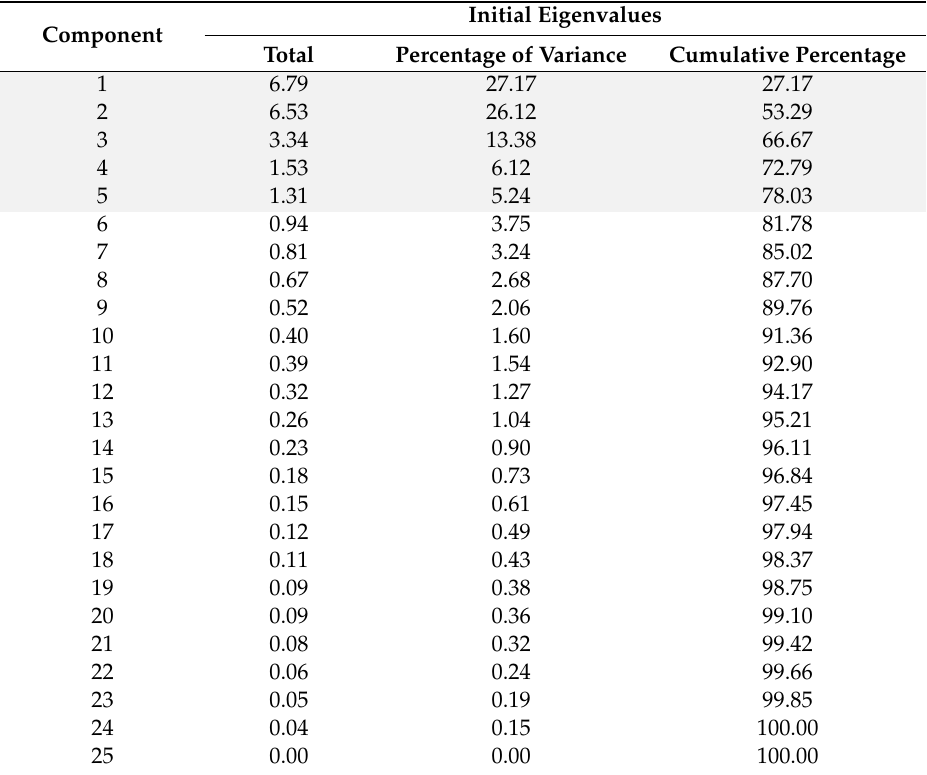
Table 9. Total variance explained §